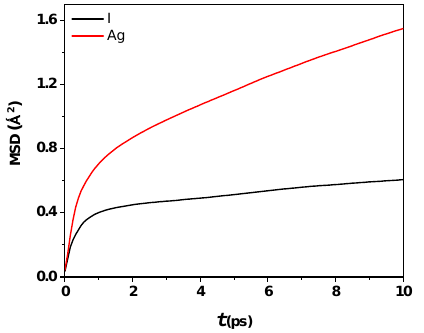
Figure 5. The behavior of the MSD of AgI-system for silver ion (red line) and iodide ion (black line) with respect to time at T = 300